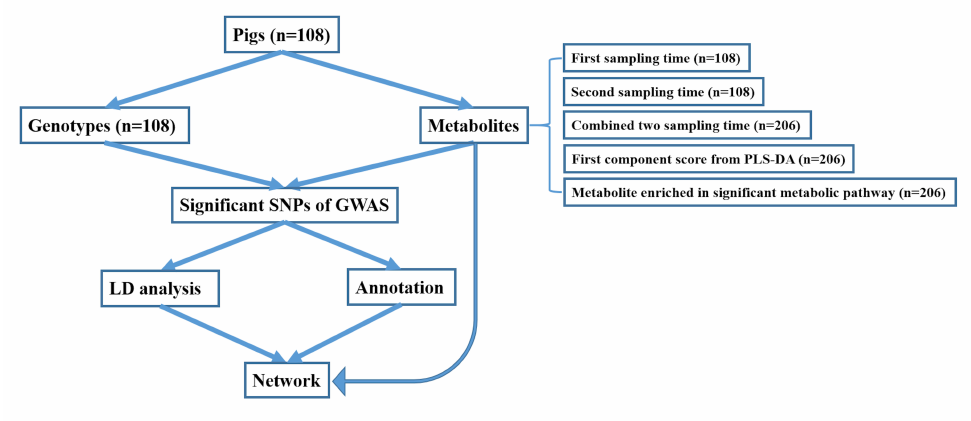
Figure 6. Overall analysis